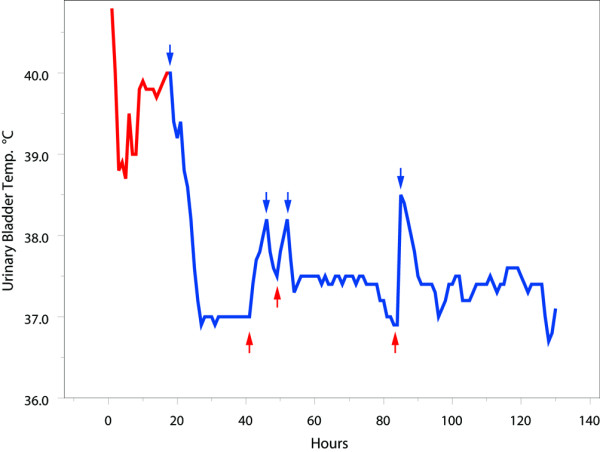
Course of core body temperature in a patient with heat stroke. The red line denotes the core body temperature while using 'conventional' temperature control methods. The blue line denotes the core body temperature while using an endovascular (CoolGard®) cooling treatment. Blue arrows denote the start of CoolGard® treatment. Red arrows denote attempts to terminate the active cooling procedure.